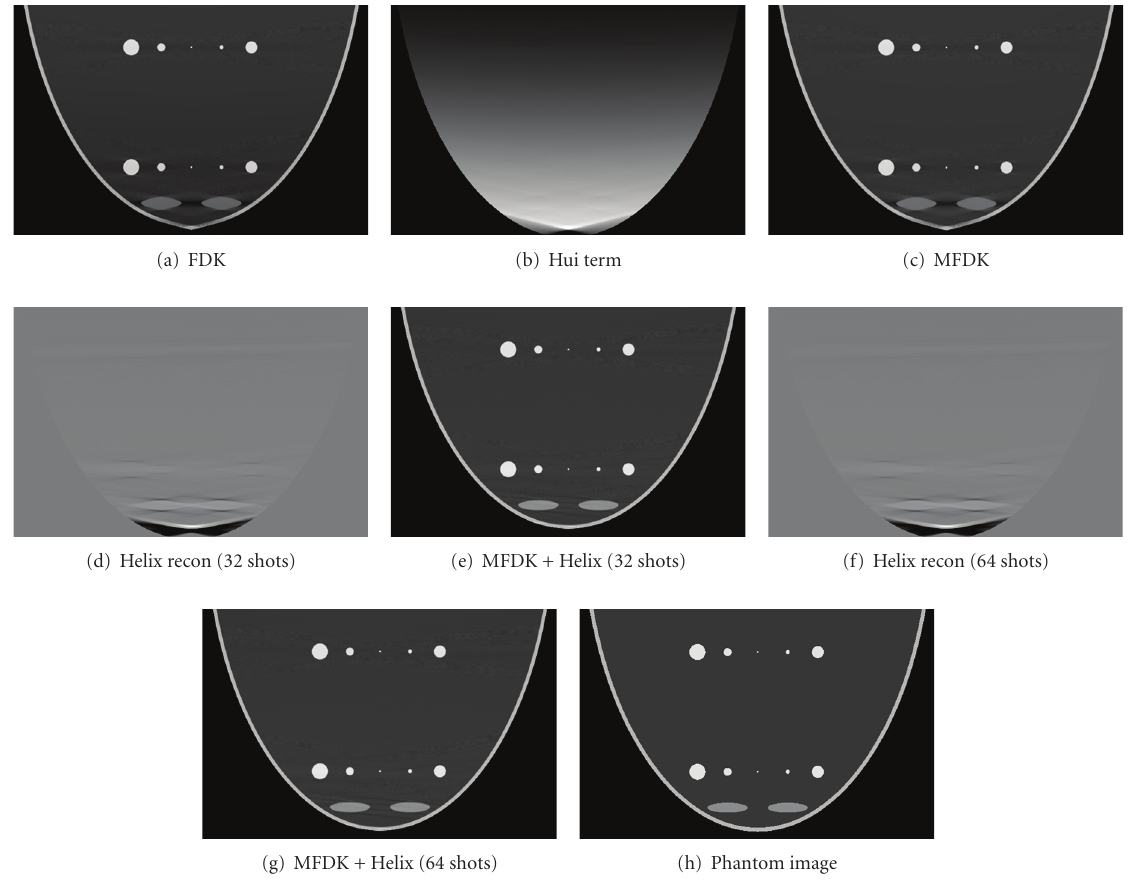
Figure 7: Central sagittal image comparison between MFDK, phantom, and circle plus partial helical term with di ff erent sampling intervals. (a) Circular FDK reconstruction; (b) circular Hui’s term; (c) MFDK reconstruction (circle FDK + Hui term); (d) partial helical reconstruction (32 X-ray shots during helix scan); (e) MFDK + Helix reconstruction (32 shots for helical scan); (f) partial helical reconstruction (64 X-ray shots during helix scan); (g) MFDK + Helix reconstruction (64 shots for helical scan); (h) phantom image of the same sagittal